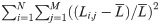
Contrast energy as a function of threshold viewing time (msec) for face and letter.Contrast energy of each image was computed as follows: ∑i=1N∑j=1M((Li,j−L¯)/L¯)2, where Li, j is the luminance of the pixel [i, j] of an image of size N by M, and L¯ is the mean luminance of the stimulus image. Each data point (solid dots) was an average of threshold viewing time across participants (n = 7) for a given blur level. The solid lines are the best fits of a linear function to the data.